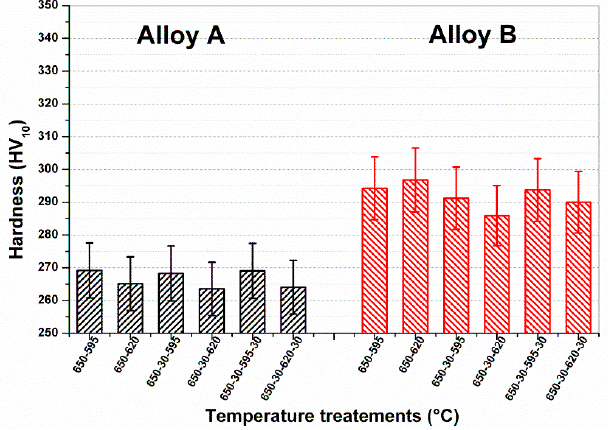
Figure 14. Hardness values for Heat A and Heat B following double tempering treatments with intermediate and final sub-zero ( − 30 °C) cooling.